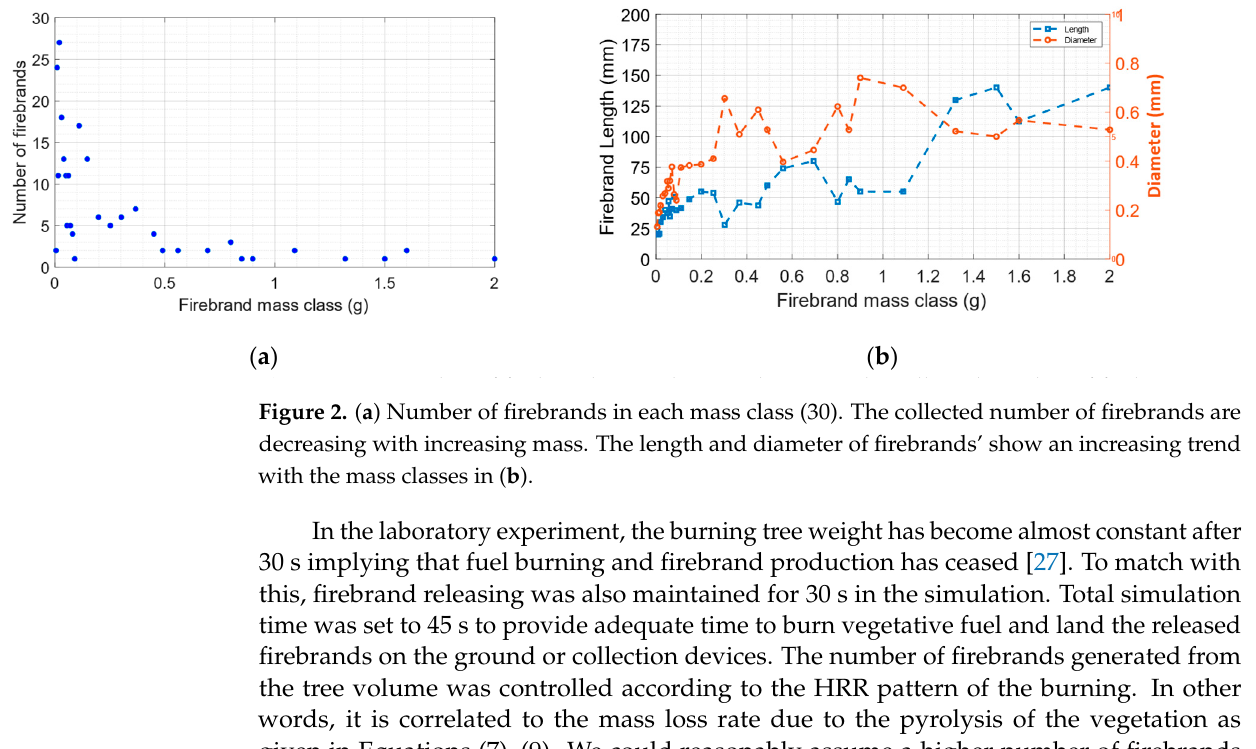
Figure 3. HRR of tree burning and the firebrand injection rate vs. time. The firebrand injection rate was adjusted according to the HRR. Here the firebrand injection rate in every 2 s time interval is represented by the bar graph. The accumulation of firebrand injection rate over the time results the total number of firebrands produced during the tree burning. The first set of firebrands was initiated around 5 s when the flame appeared at the bottom of the tree. The firebrand generation pattern was synchronized with the HRR pattern as much as possible to fulfil the total generation number (a multiplication of the collected number of firebrands (70 pieces)) of firebrands. During the laboratory experiment, no wind was imposed on the burning tree [9] and the simulations were also conducted in absence of wind replicating the laboratory experiment. The firebrands pyrolyzing was not accounted here assuming the time between firebrands initiating and landing is not sufficient for a significant pyrolyze and mass reduction of them. The firebrand burnout was also ignored to match with the experiment because they quenched as soon as landing on the water filled trays. The total mass of a particular firebrand type landed on a tray (FDS device) could be found at the end of the simulation. The number of firebrands was calculated by dividing the total mass by the individual mass of that firebrand class. As this continued for all the landed firebrand classes, we could calculate the total number of firebrands collected, the total mass and the number distribution of them. The grid convergence results, validation of mass loss data